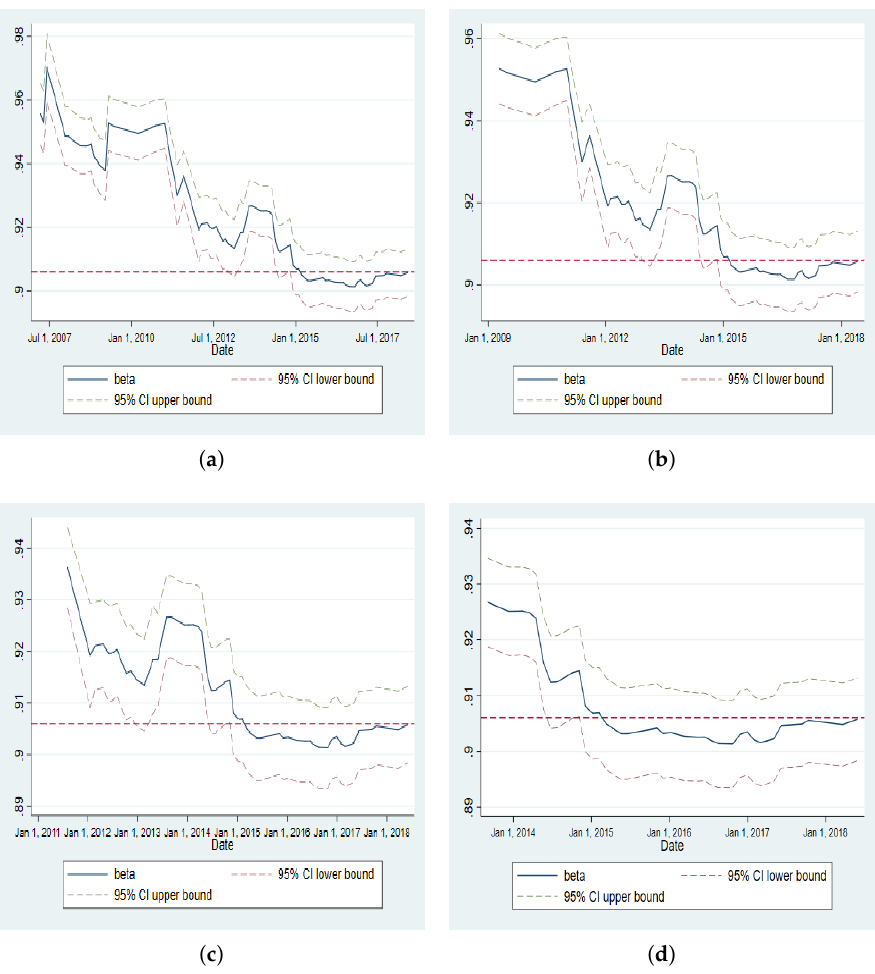
Figure A8. Dynamics of the persistence parameter for the BRVMC index using recursive rolling regression. These graphs plot the persistence parameter estimated using rolling regression. The date is the end date for a selected window. In ( a ), the persistence parameter is around 0.95 using recursive rolling regression with a window whose end date is 1 July 2007. The dot lines denote the 95% level confidence interval. The persistence parameter declines slightly over the estimation period. This decrease in the persistence parameter can be considered an insight into the improvement of the efficiency of the market. ( a ) Dynamics of the persistence parameter using rolling regression with a 2-year window; ( b ) Dynamics of the persistence parameter using rolling regression with a 4-year window; ( c ) Dynamics of the persistence parameter using rolling regression with a 6-year window; ( d ) Dynamics of the persistence parameter using rolling regression with an 8-year